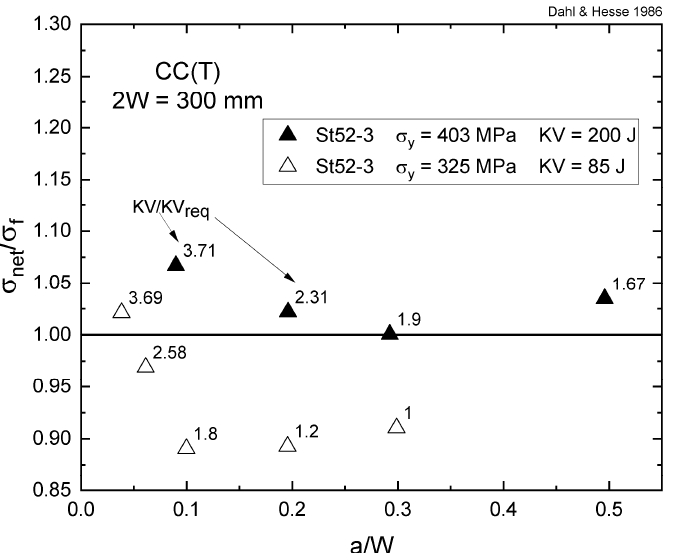
Figure 11. Proportional net section stress values divided by flow stress for the data in Figure 8 as a function of relative crack length and related to the ratio between the Charpy-V impact energy and estimated required impact energy to obtain the plastic limit load.